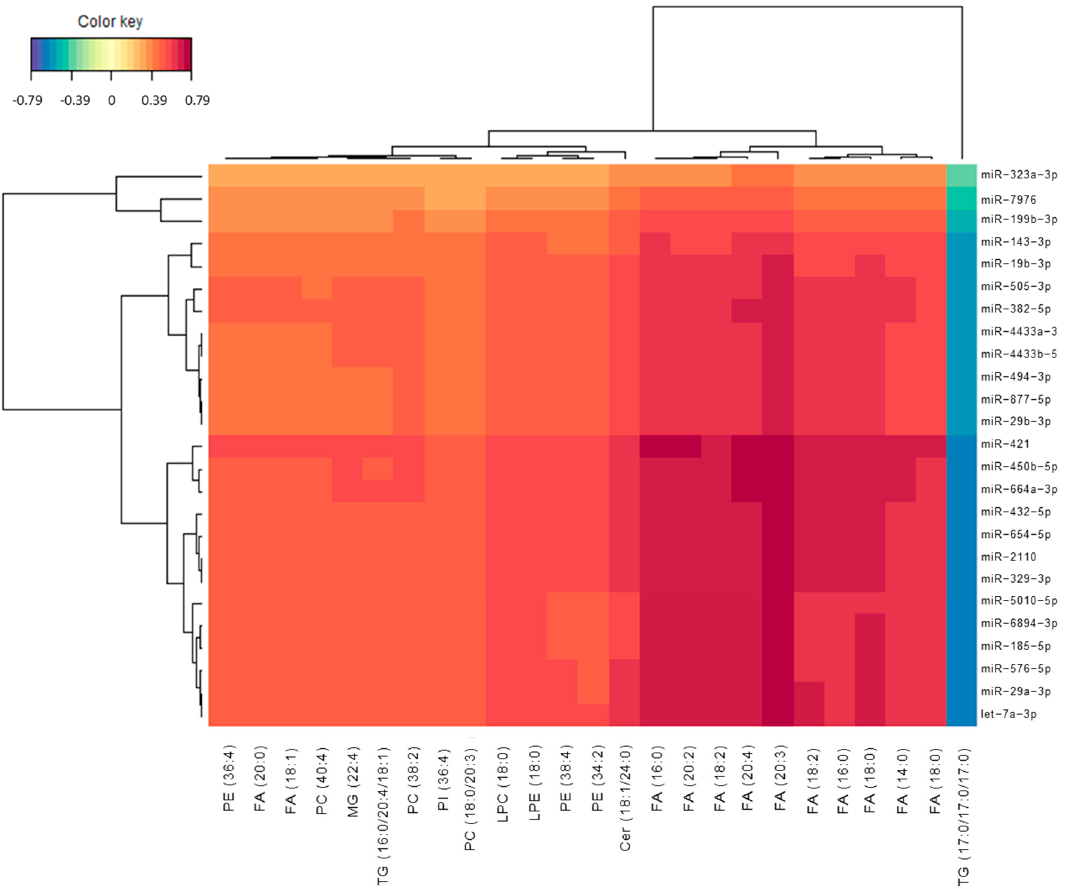
Figure 3. Heatmap representing correlations between miRNAs and lipid variables. Red colour represents positive correlations and blue colour represents negative correlations.